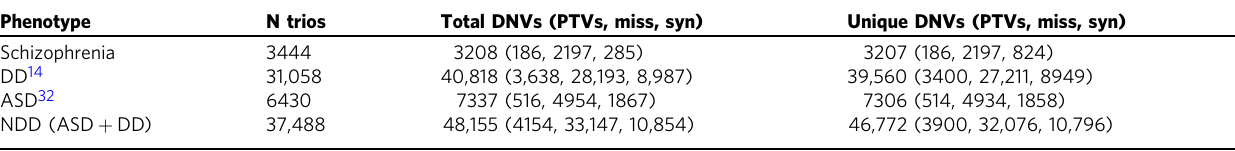
Table 5 Summary of single-nucleotide variants included in the allelic pleiotropy de novo